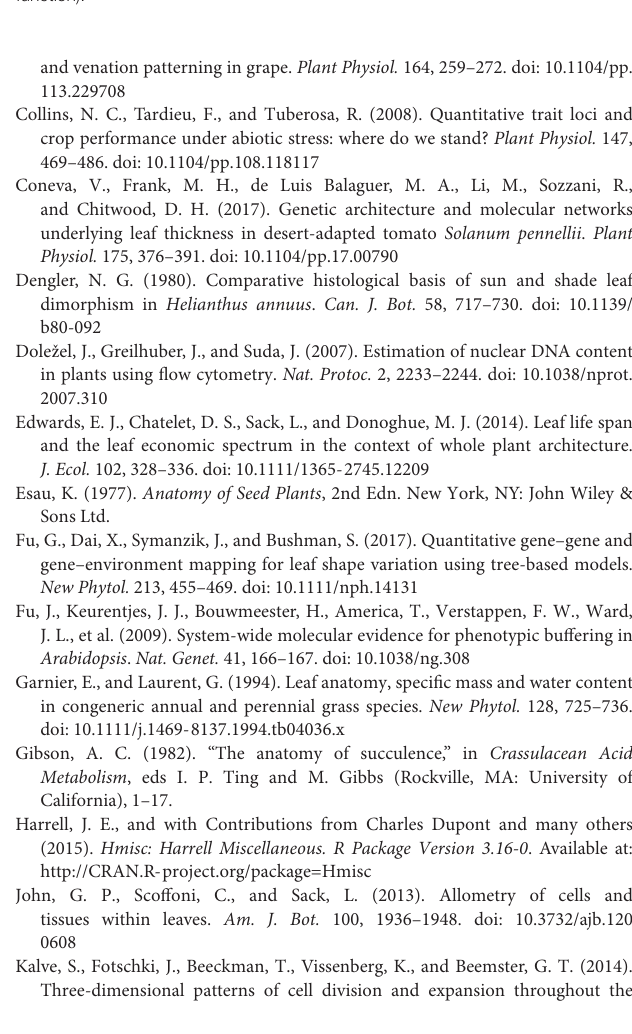
FIGURE S3 | Comparison of the total number of rosette leaves and the leaf 5 aspect ratio of Ler and Cvi. ∗∗∗ p < 0.001. FIGURE S4 | Representative flow cytometry histograms of Ler and Cvi rosette leaf 5. Each peak is labeled with the presumptive nuclear size (2C–32C). TABLE S1 | Summary of the position, LOD score, and 1.5 LOD interval of significant QTL peaks for leaf thickness, LMA, flowering time, total leaf number, sucrose content, and hypocotyl length (R/FR).